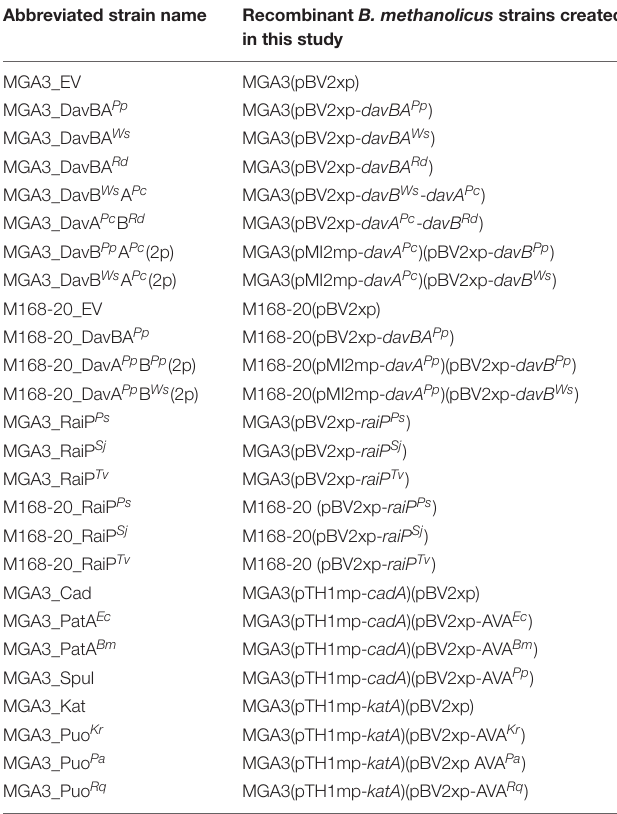
TABLE 4 | List of B. methanolicus strains used in this study with abbreviated strain